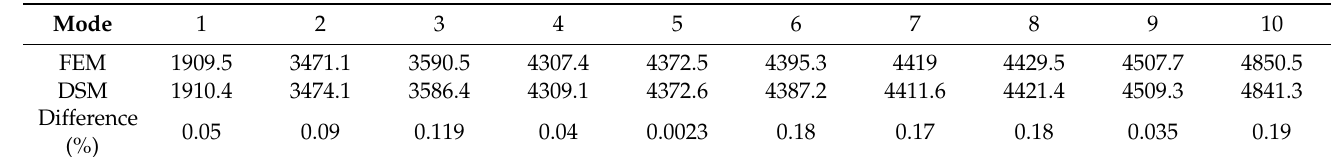
Table 4. Natural Frequencies, ω ( rad / s ) of Euler–Bernoulli Beam Analysis with no spherical joint in Topology 1, Original Configuration.